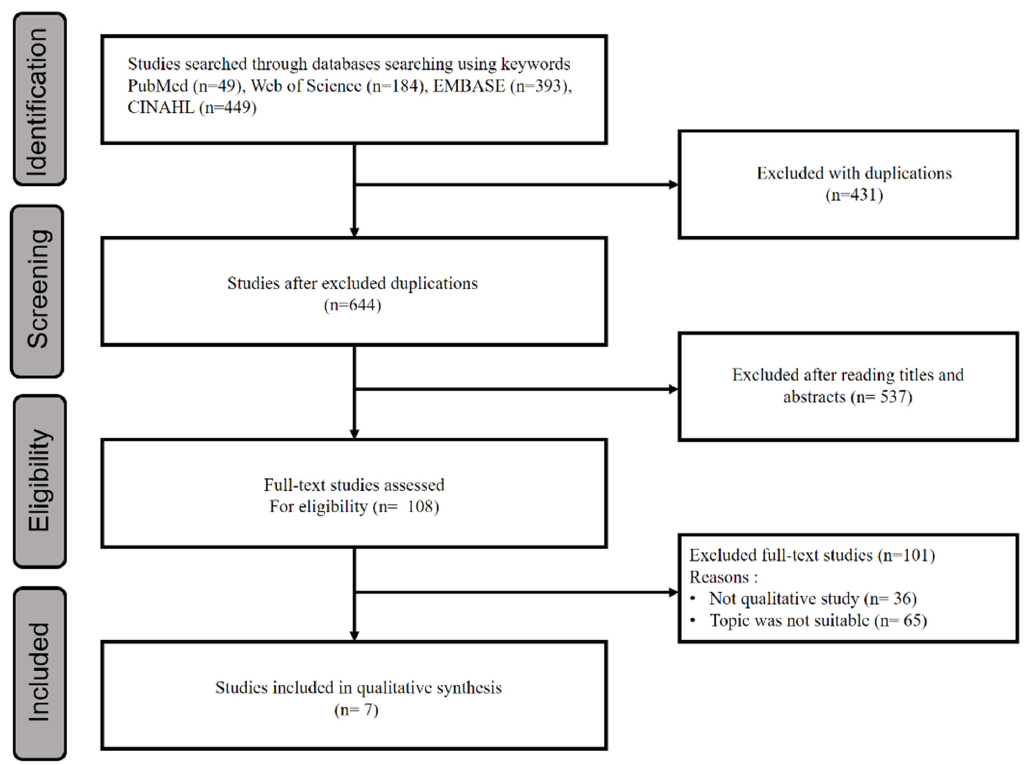
Figure 1. Flow chart of the systematic review used in this study.